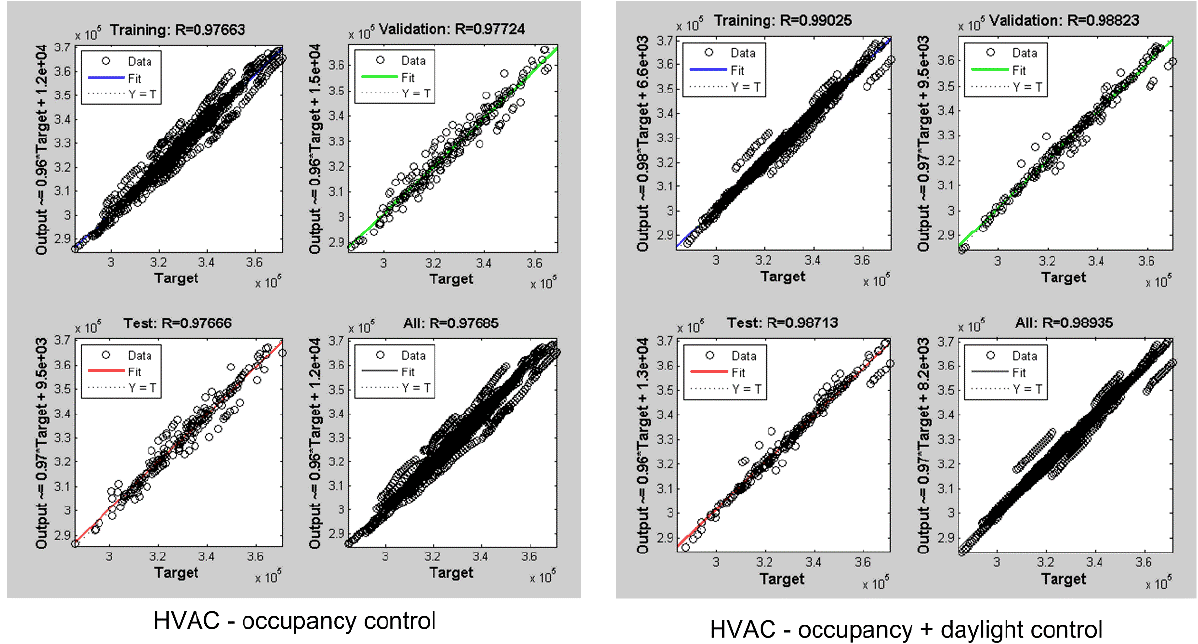
Figure 10. Neural network training and testing results for HVAC energy consumption.